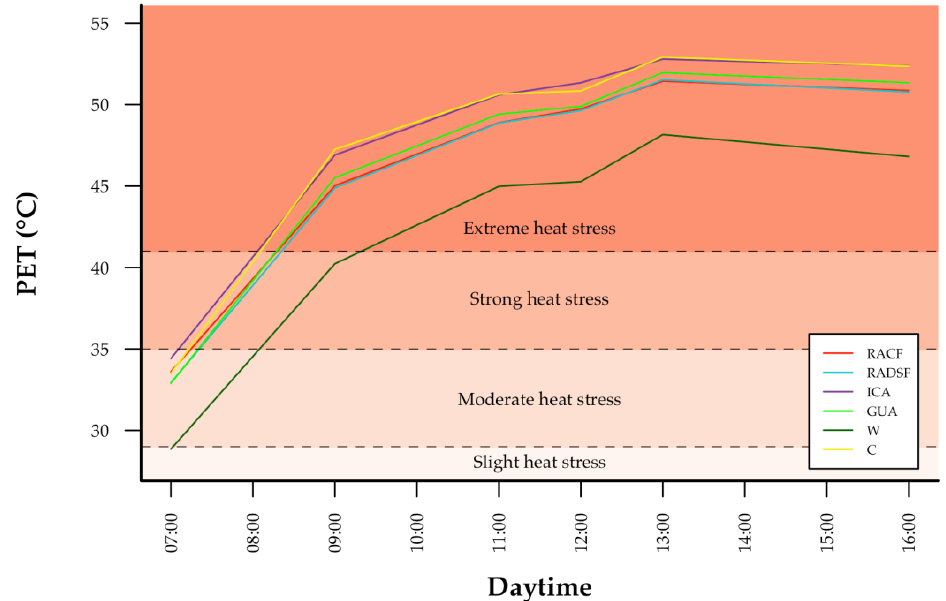
Figure 10. Mean PET values at different daytimes for the main land cover classes (RACF = residential areas with continuous fabric; RADSF = residential areas with discontinuous and sparse fabric; ICA = industrial and commercial areas; GUA = Green Urban Areas; W = woodland; C = crops). Background colors indicate the grade of physiological stress based on PET ranges for Western/Middle Europe (internal heat production: 80 W, heat transfer resistance of the clothing: 0.9 clo) according to Matzarakis et al. [28].